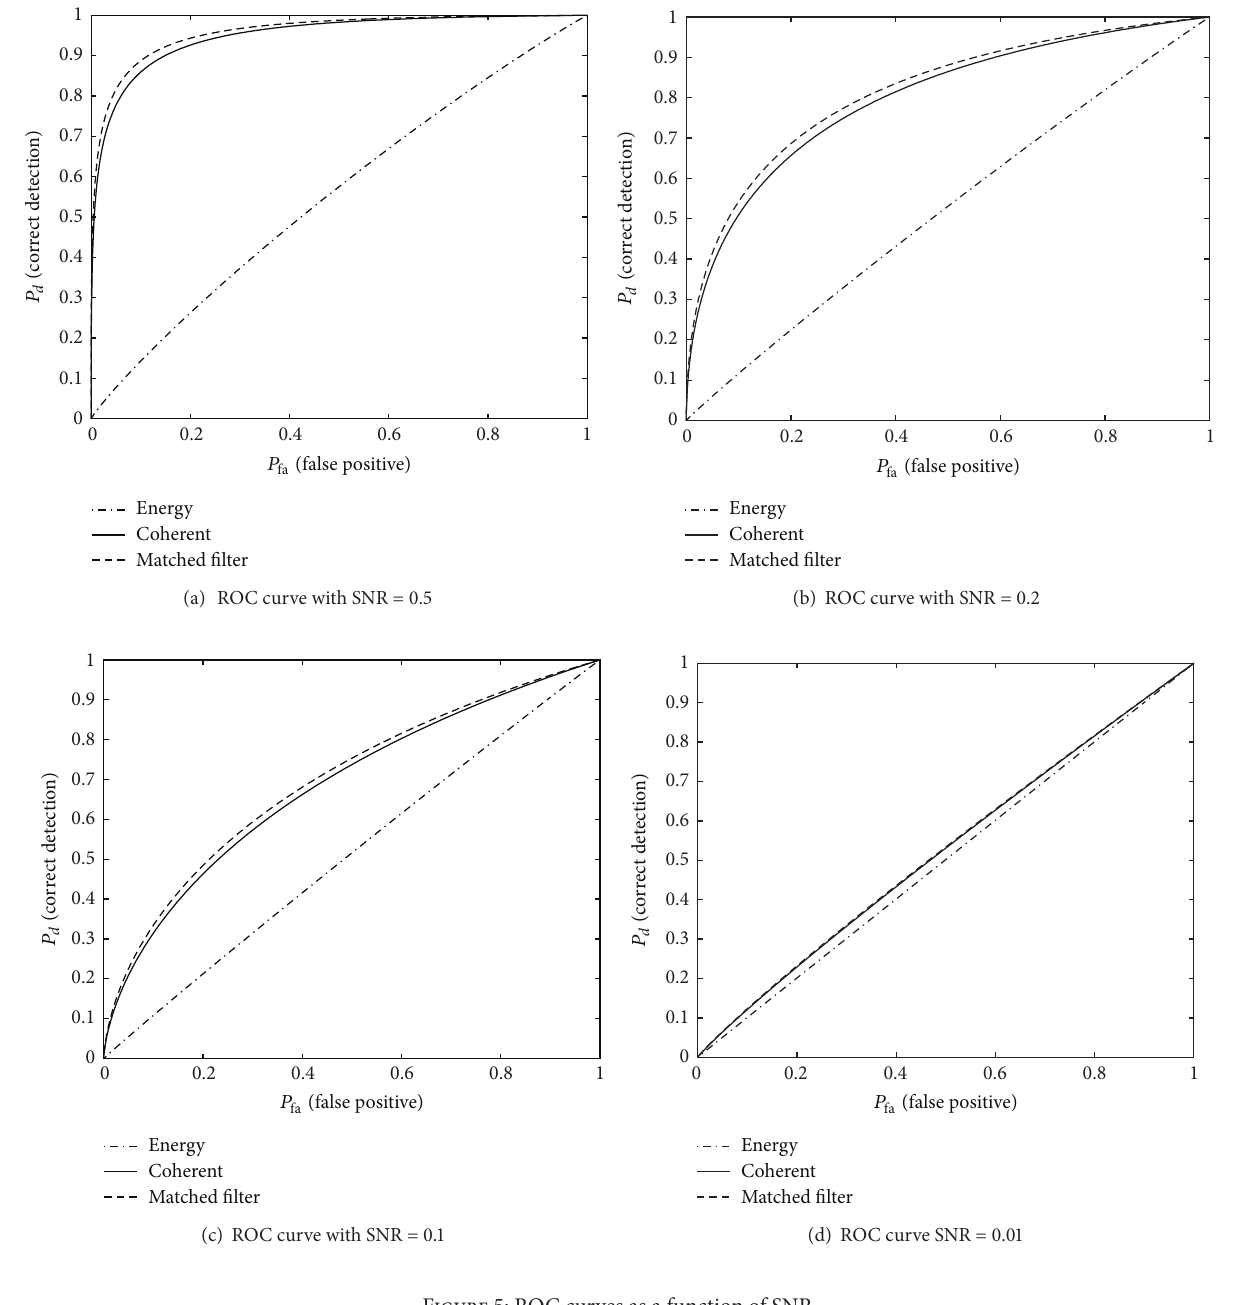
Figure 5: ROC curves as a function of